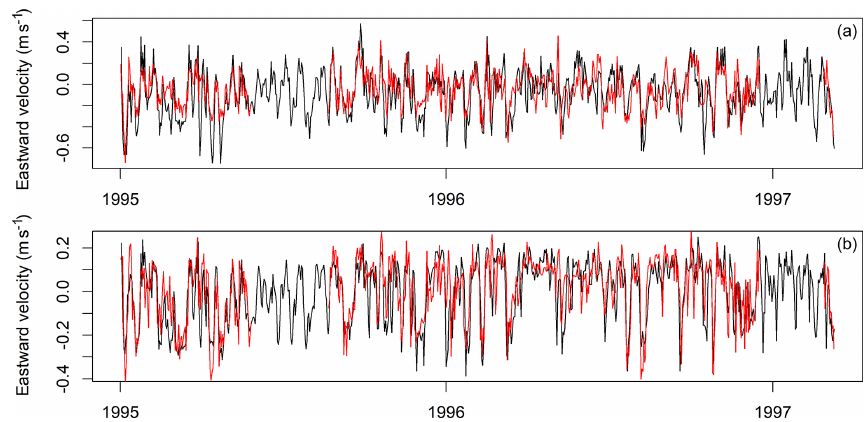
Figure 5. Eastward velocity at station Darss Sill (54.7 ◦ N, 12.7 ◦ E): (a) at 3m depth; (b) at 17m depth. Black line: model results. Red line: ADCP